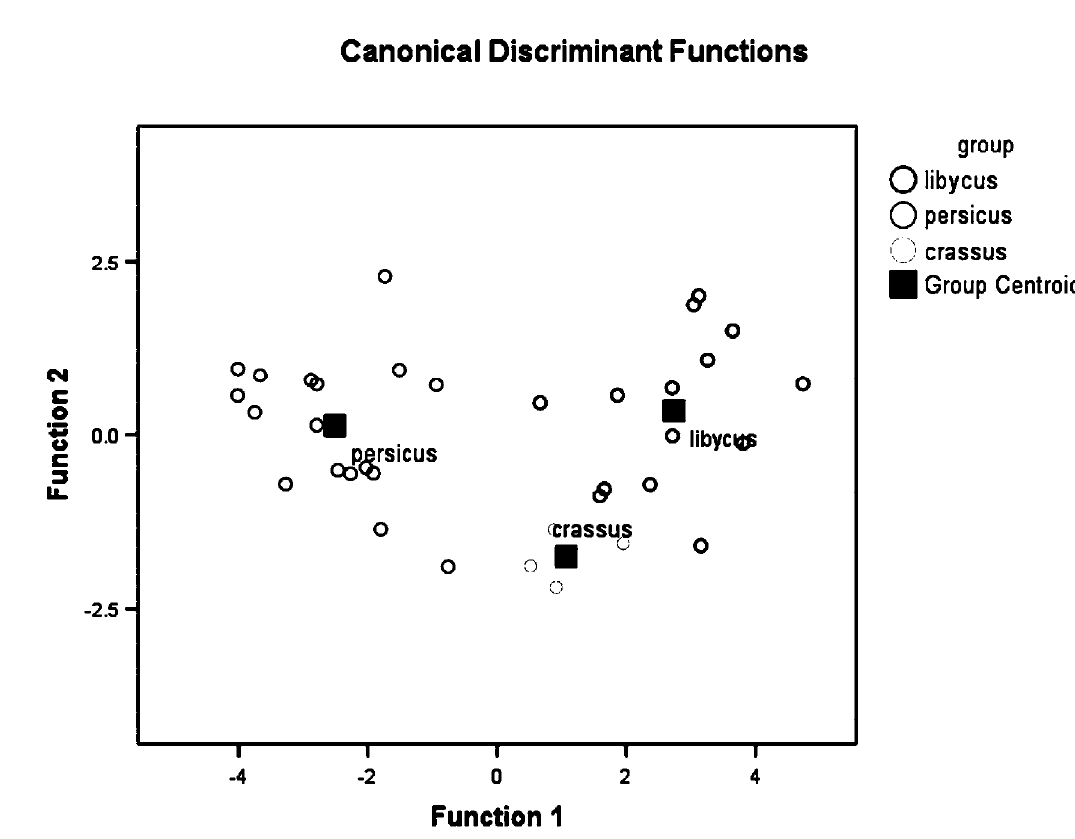
F IG . 4. - Discriminate Function Analysis of meatus part between